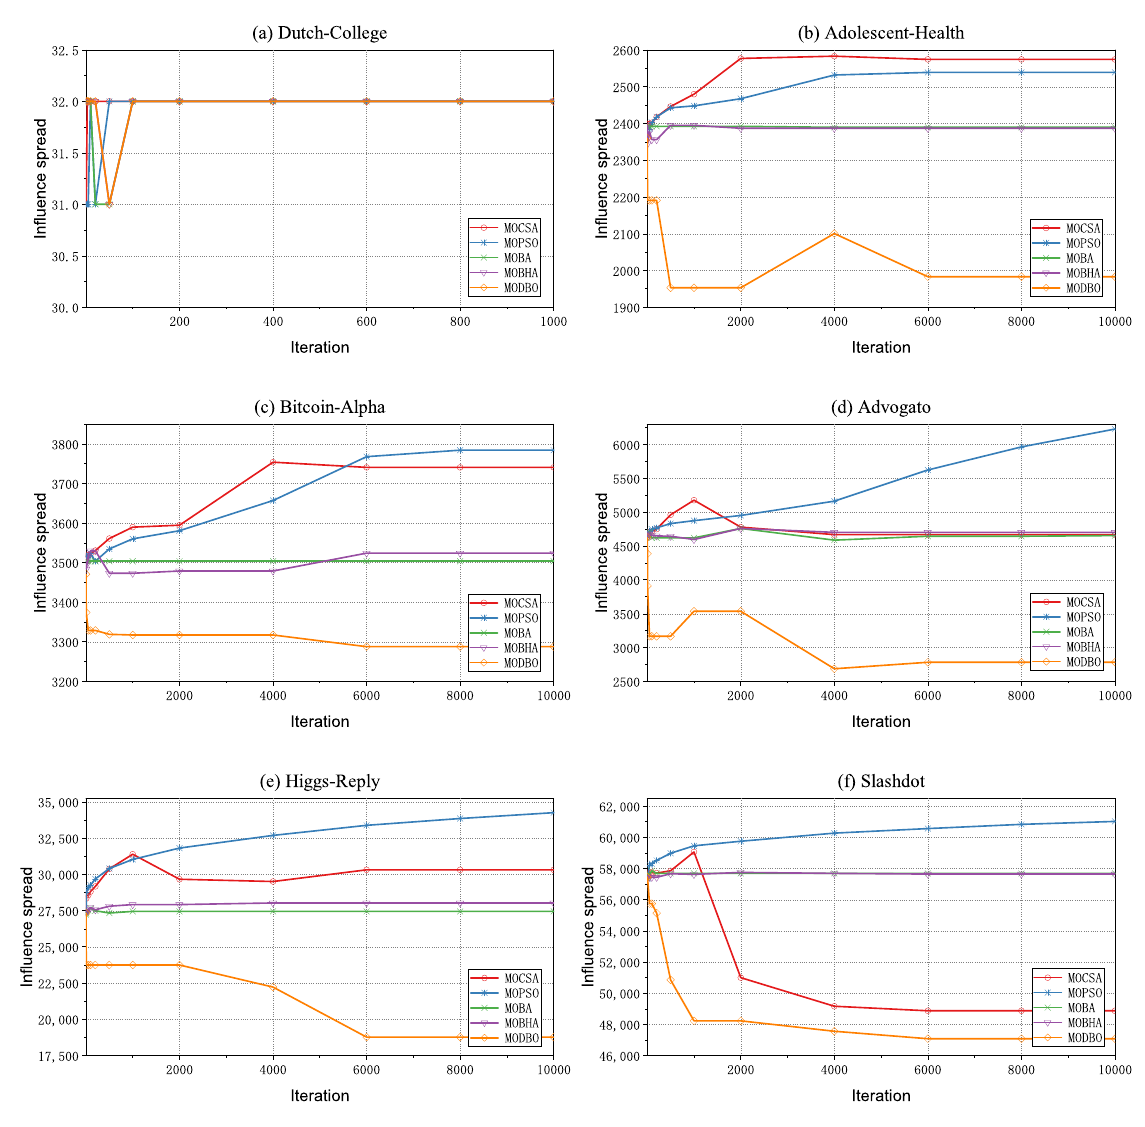
Figure 4. Influence spread of different algorithms on six real social